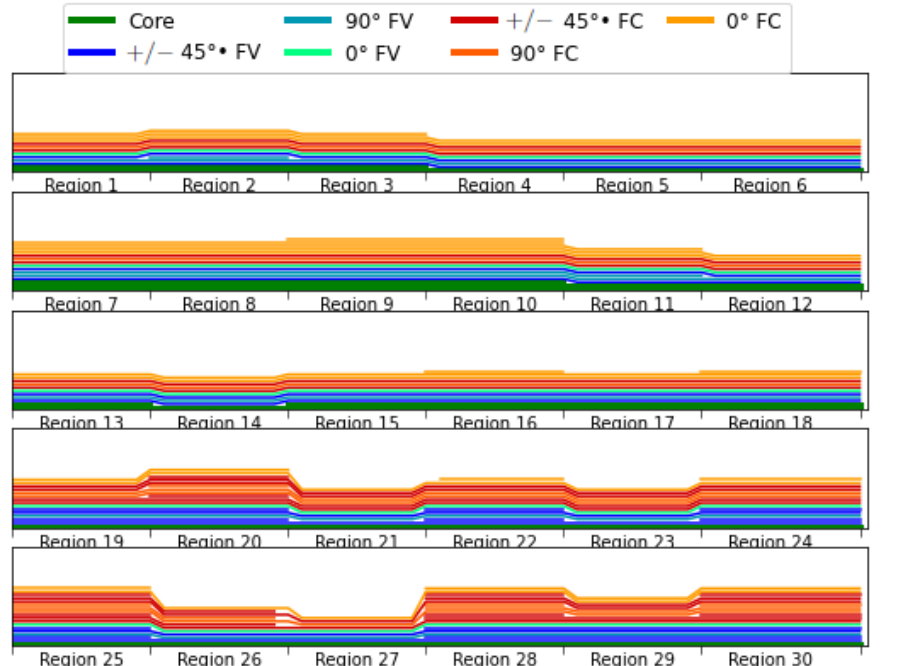
Figure 14. Schematic representation of the laminate selected through MCDM from the MOSOP2 PF.